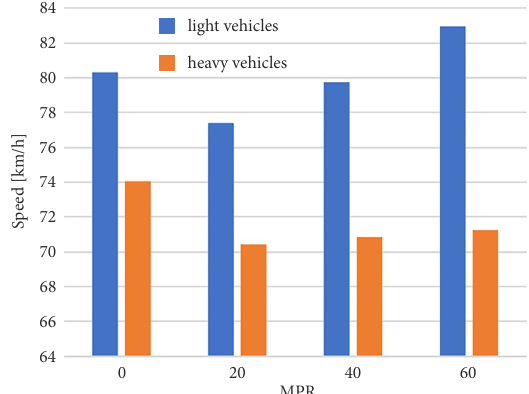
Figure 11. Speed of light vehicles (blue) and of heavy vehicles (orange) for different MPRs [km/h] – headway adaptation strategy